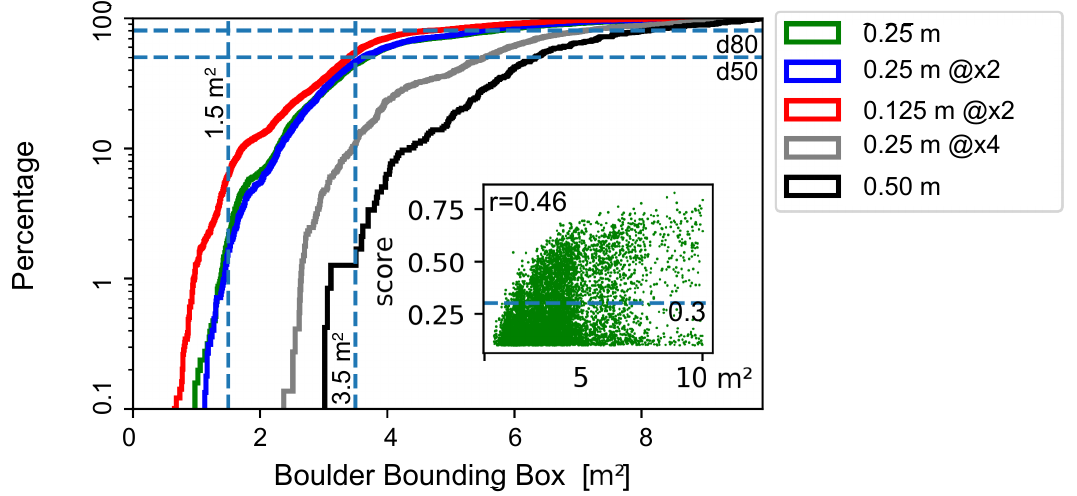
Figure 12. Cumulative area distribution of bounding boxes from 0 m 2 to 10 m 2 . The scatter plot inset demonstrates the correlation between bounding box area and object score. The score threshold of 0.3 is indicated by a dashed blue